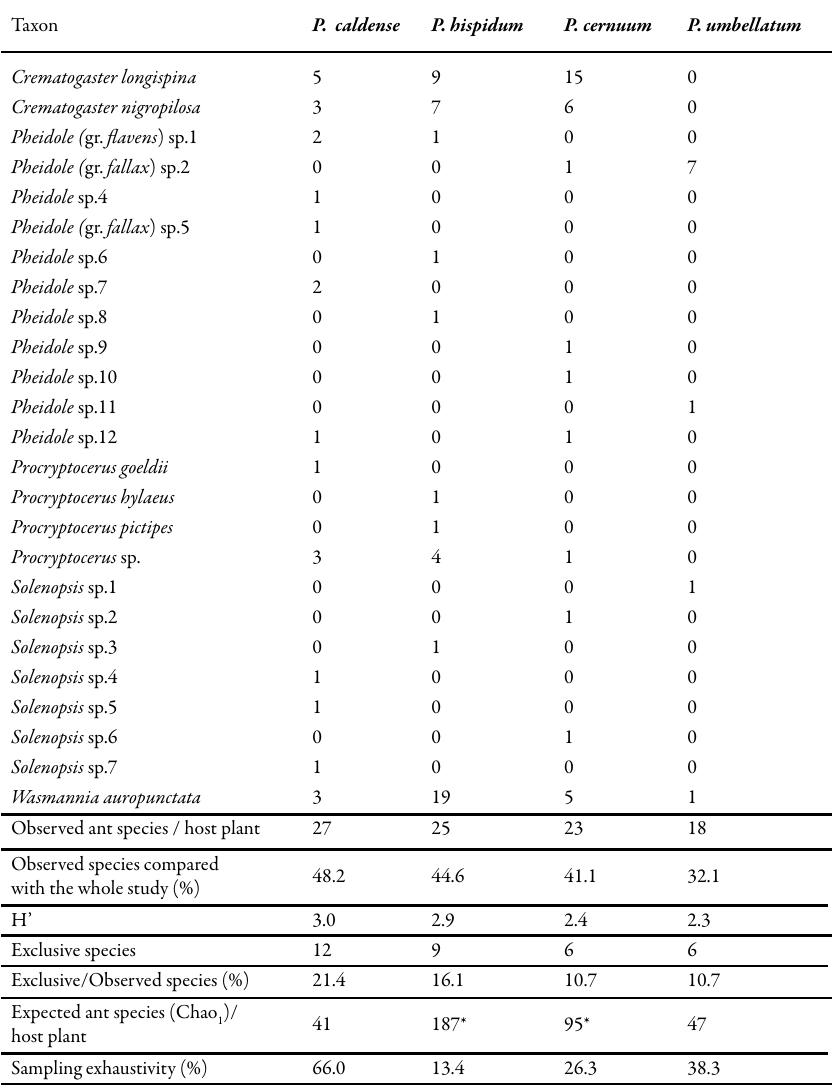
Table 1. Ant species collected, and related ecological characteristics, on four species of Piper , September 2010 to May 2011, Serra Bonita RPPN, Bahia, Brazil. *probable artifacts due to the large proportion of singletons in the sampled series